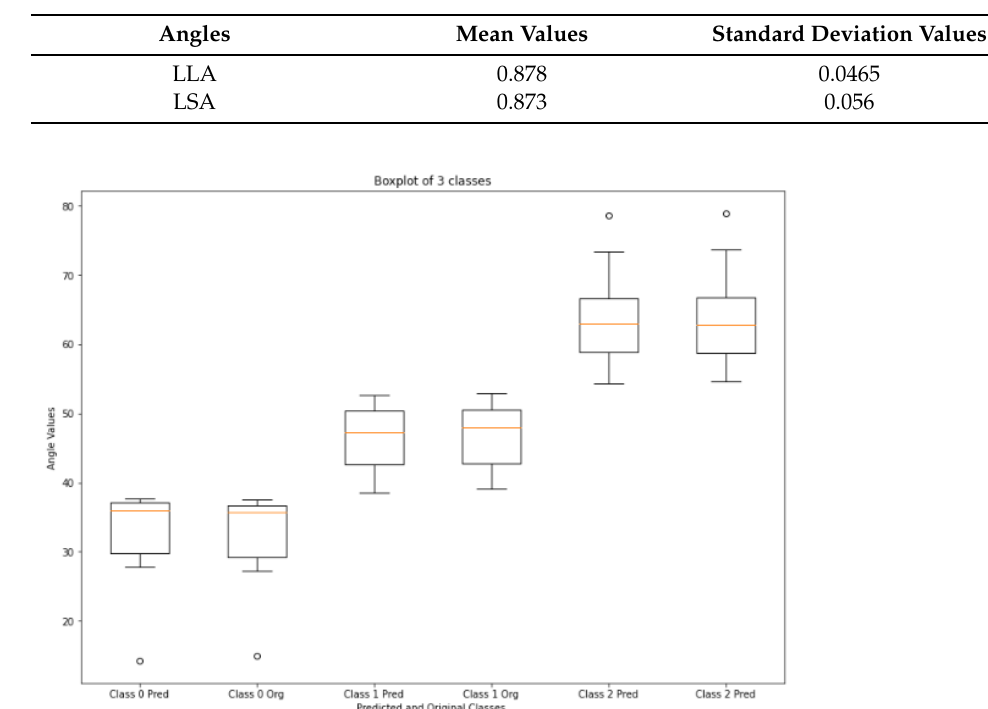
Figure 13. Boxplot of hypo, normal, and hyper lumbar lordosis. All the predicted and original angle values of each class lie in the same